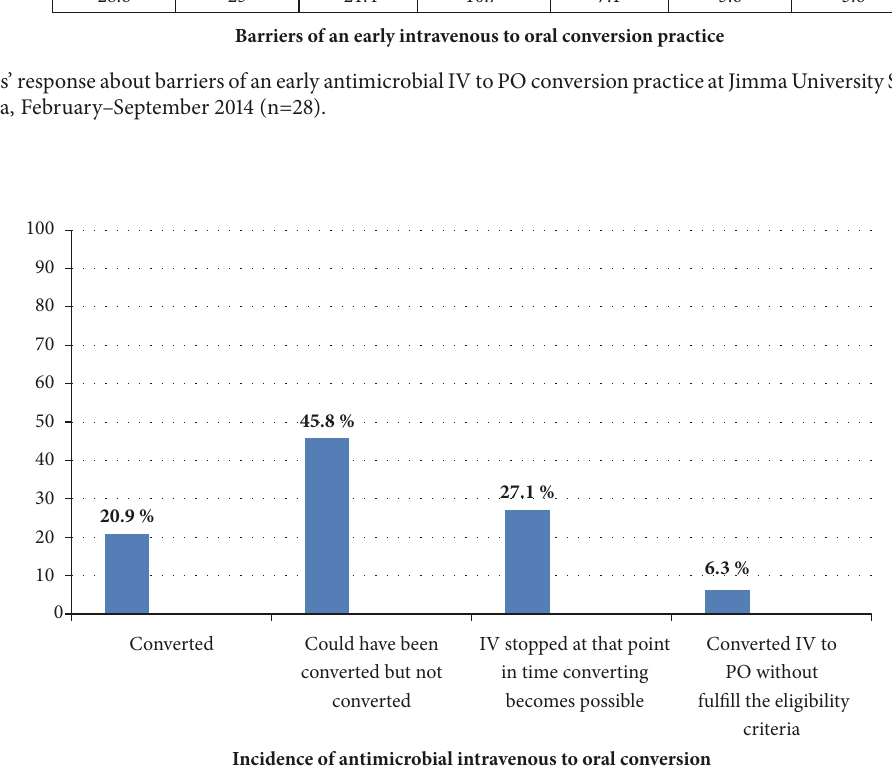
Figure 2: The percentage of patients in the incidence of antimicrobial IV to PO conversion at Jimma University Specialized Hospital, South West Ethiopia, February–September 2014